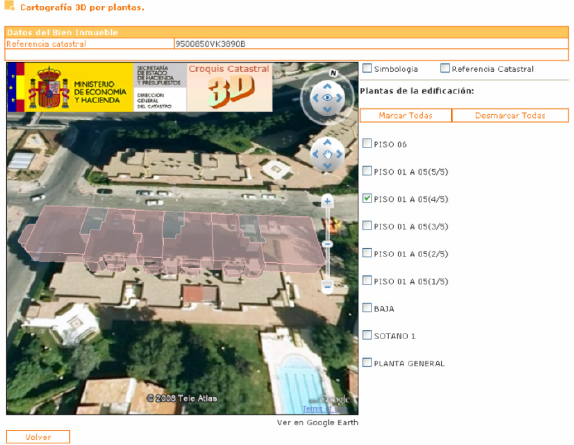
Figure 5. 3D cadastral sketch. Figure courtesy of Luis Ignacio Virgós Soriano and José Miguel Olivares García, General Direction of Cadastre of Spain.